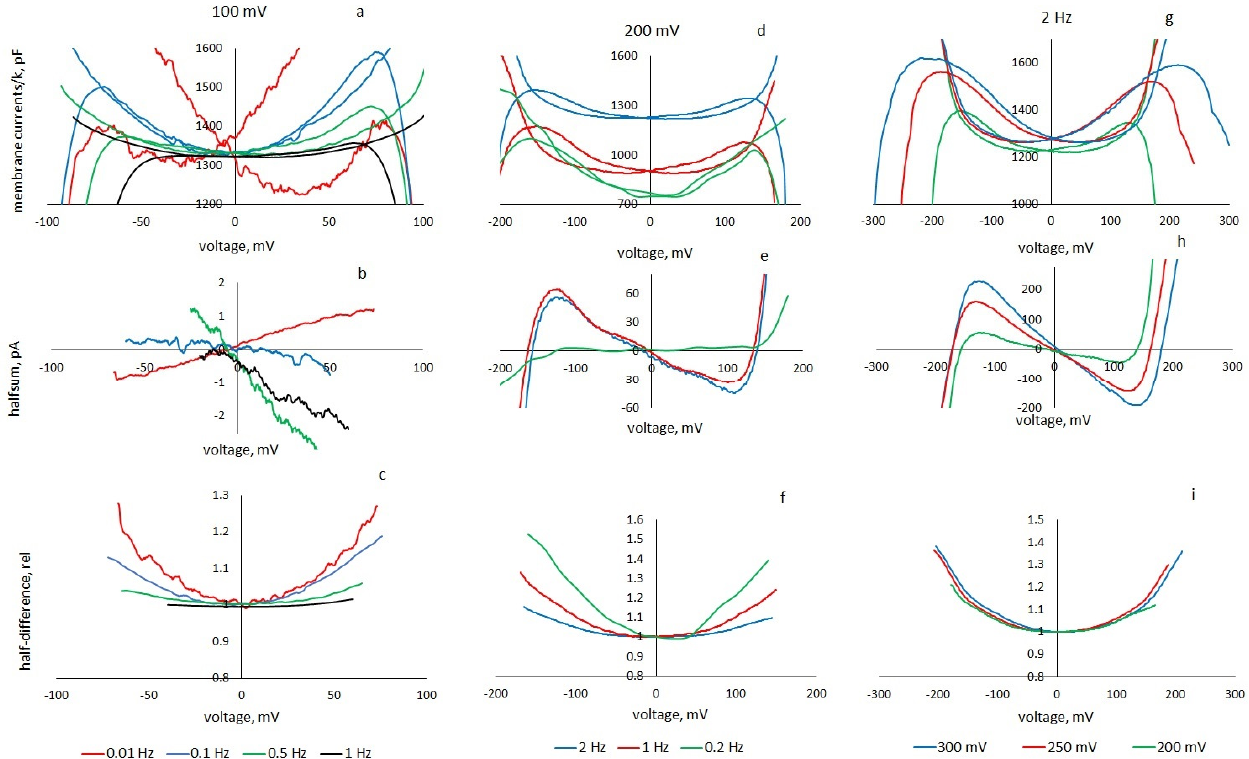
Figure 5. Pinched-hysteresis loops ( a , d , g ), negative apparent conductance ( b , e , h ), capacitance curves ( e , f , i ) showing coefficient β values for membranes of azolectin, 0.1 M KCl depending on the characteristics of the triangular voltage. Left column ( a – c ): triangular voltage amplitude 100 mV, frequencies 0.01, 0.1, 0.5 and 1 Hz ( β = 4, 11, 29, 47 V − 2 ). Middle column ( d – f ): triangular voltage amplitude 200 mV, frequency 2, 1 and 0.2 Hz. Right column ( g – i ): frequency 2 Hz, triangular voltage amplitude 200, 250 and 300 mV.